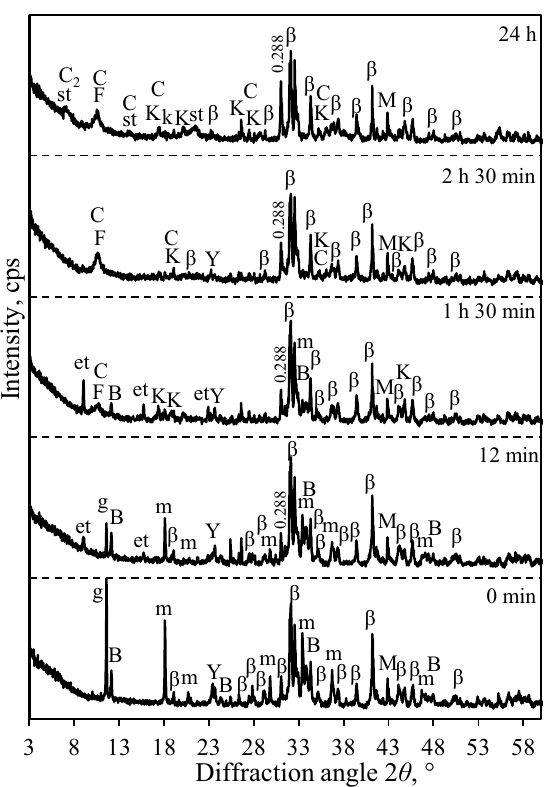
Figure 6. XRD patterns of S1-1100 sample after different duration times of hydration. Indexes: m-mayenite, β-larnite (β-C